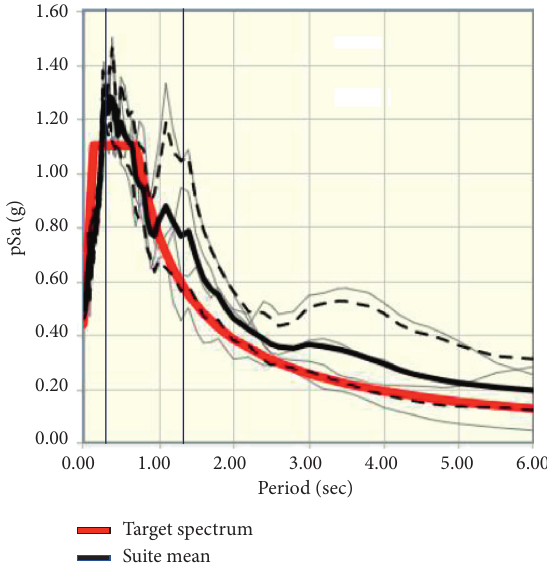
Figure 1: Design response spectrum for structures located in near- fault